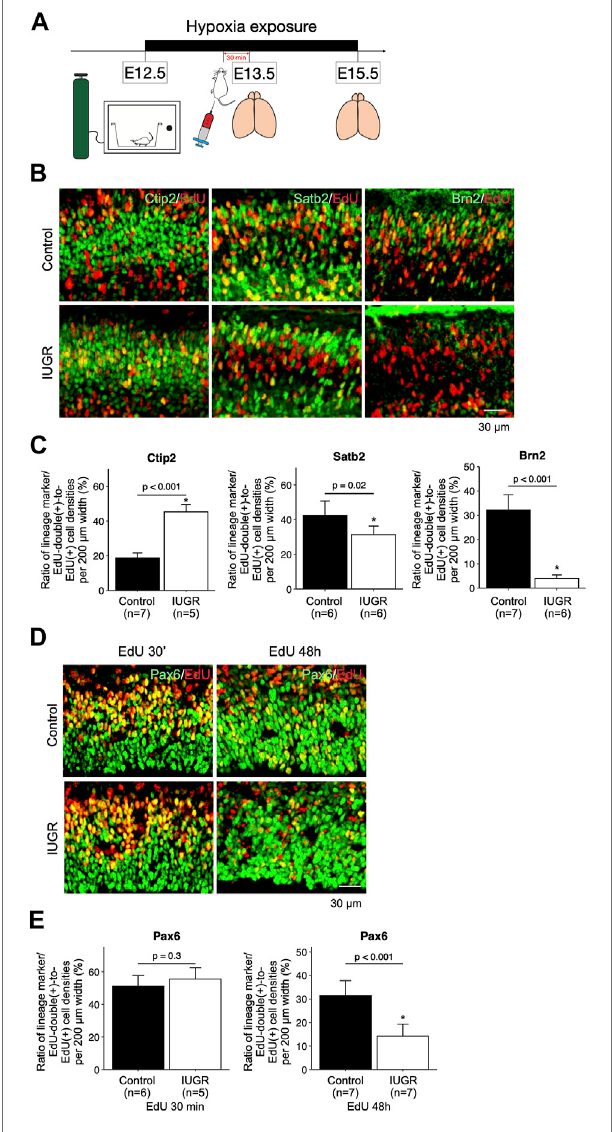
FIGURE 2 | Delayed cortical neurogenesis and decreased number of fetal NSCs in the intrauterine growth restriction (IUGR) mouse fetal brain. (A) Schematic representation of the experimental design. (B) Immuno fl uorescence staining showing cells co-expressing EdU and Ctip2, Satb2, or Brn2 markers in the control and the IUGR groups. (C) Quanti fi cation of the cells in Panel B showing the proportion (shown in percentage) of EdU/lineage marker-co-expressing cell density to total EdU- expressing cell density per view. (D) Immuno fl uorescence staining showing cells co-expressing EdU and Pax6 at the indicated time points in the control and the IUGR groups. (E) Quanti fi cation of the cells in panel D showing the proportion (shown in percentage) of EdU/Pax6-co-expressing cell density to total EdU-expressing cell density per view.